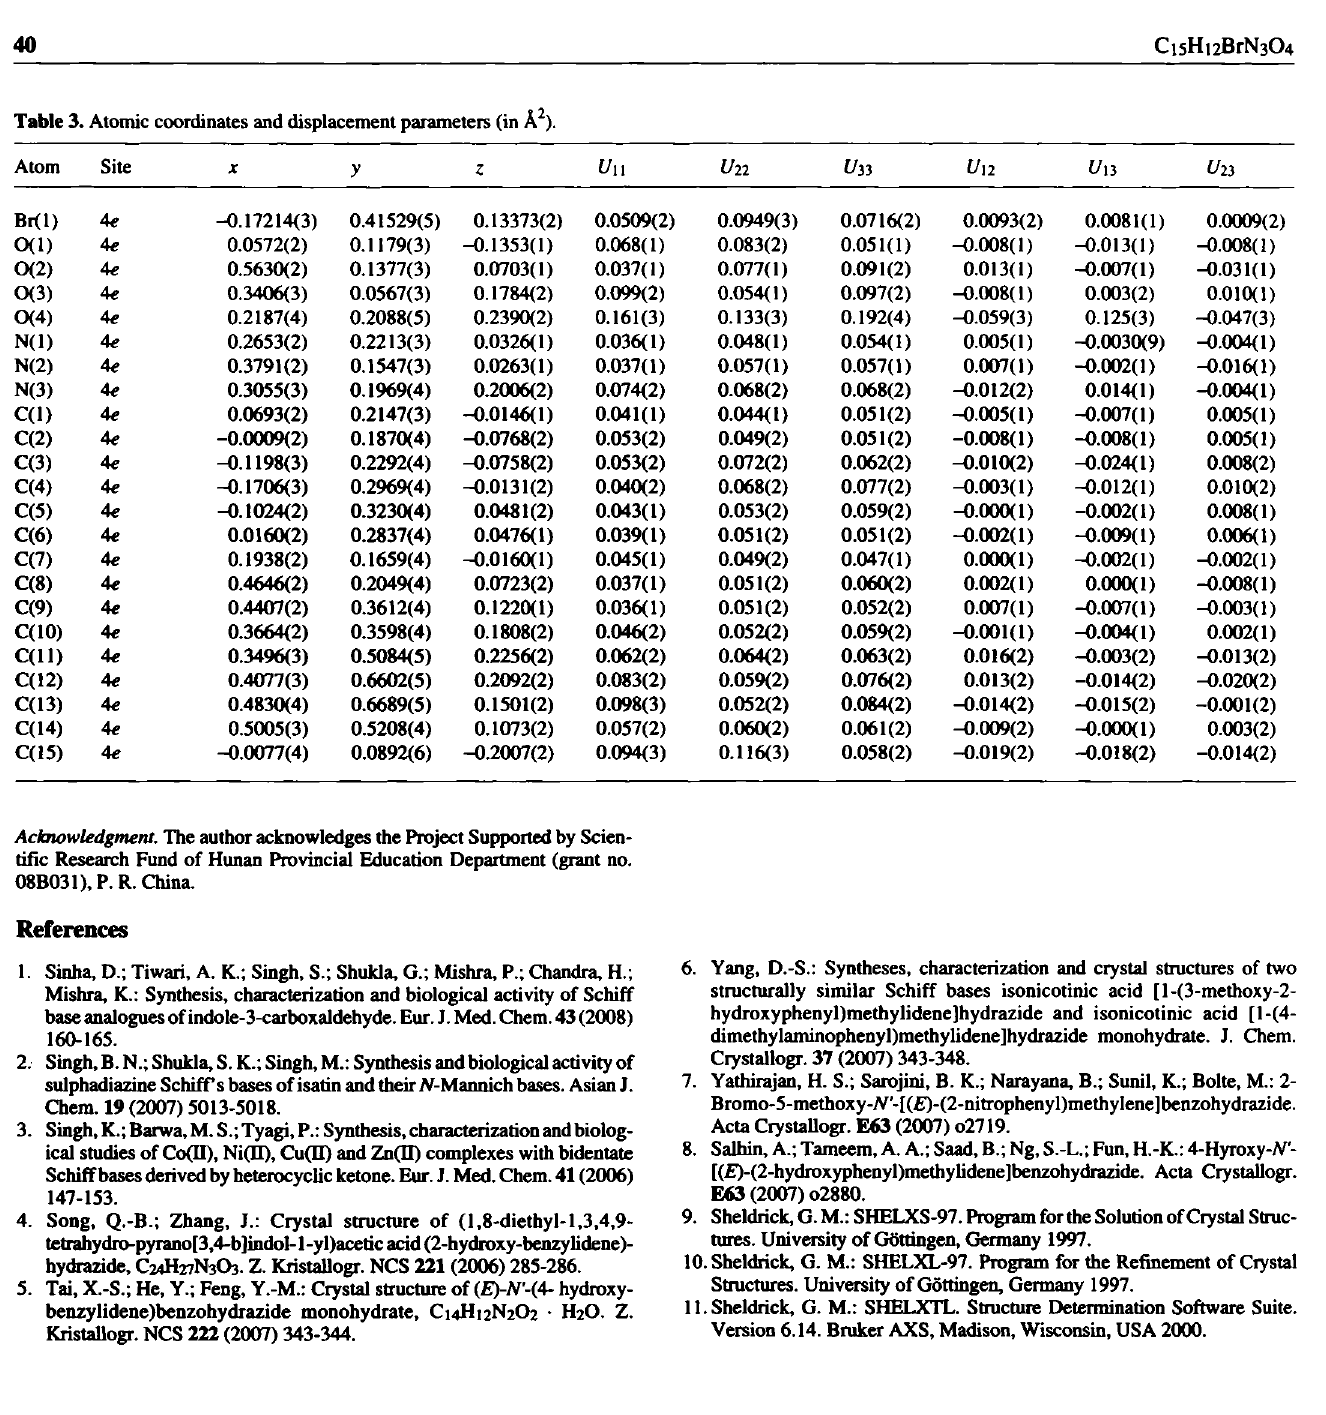
Table 3. Atomic coordinates and displacement parameters (in Â 2